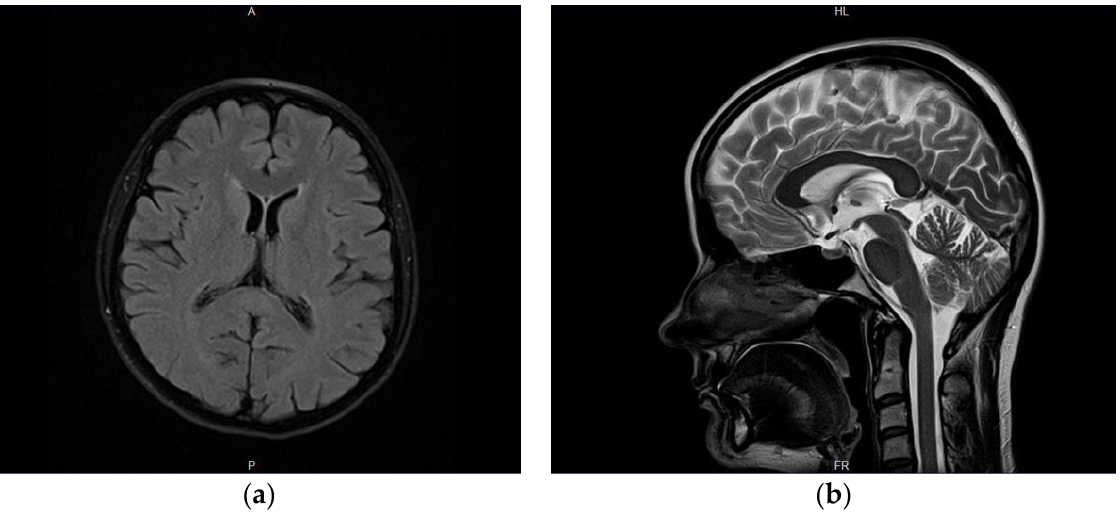
Figure 3. Another follow-up MR examination after 13 months. Substantial regression of the SCC lesion; discrete, indistinct hyperintensity on axial T2w-TIRM (dark fluid) images ( a ). No signal abnormalities were visible within splenium on other MR sequences — as visible on conventional T2-weighted (blade) sagittal image ( b ).